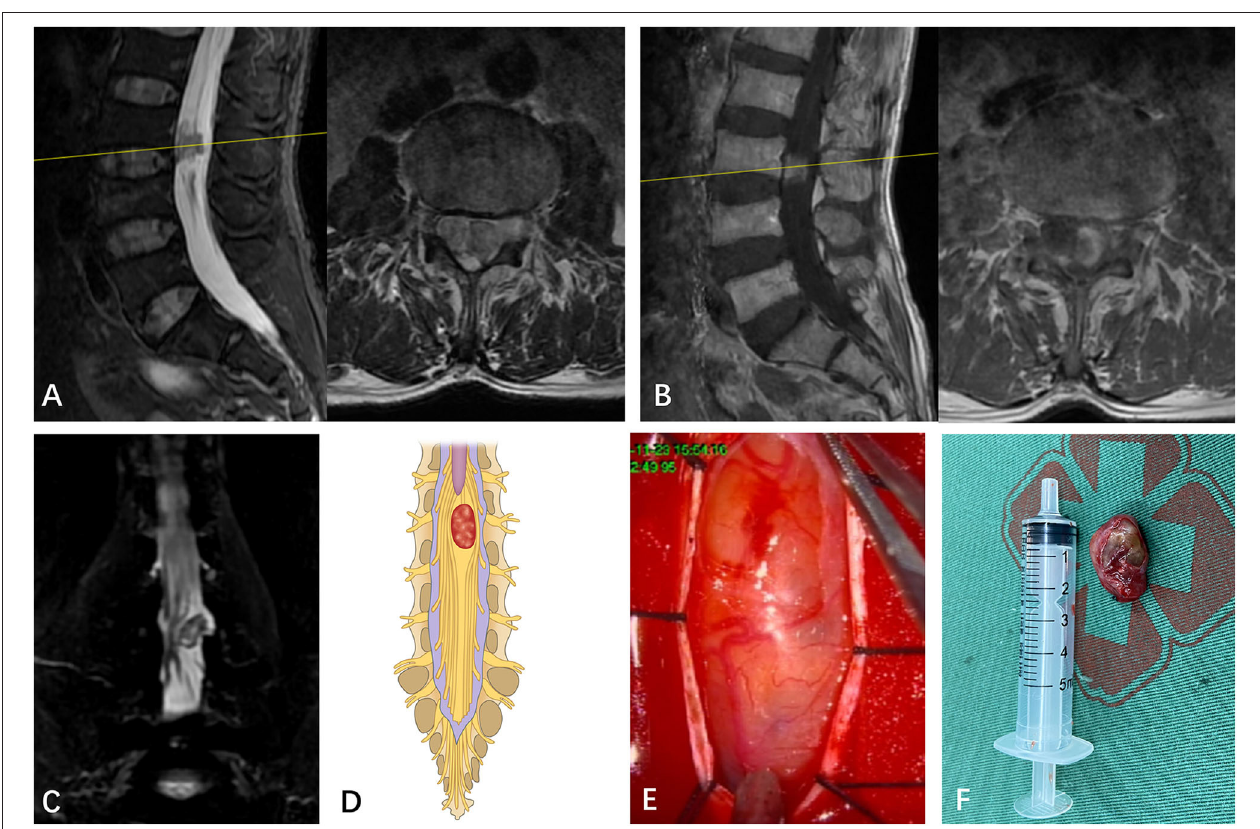
FIGURE 2 | (A) A subdural mass with hypersignal T1 and T2 was identified on a segment of T12 in a 58-year-old man via preoperative MRI. (B) The mass presented inhomogeneous enhancement via Gd MRI. (C) Though both preoperative MRI and Gd MRI did not identify the spatial relationship between the tumor and the spinal nerve, the CMRI clearly showed that a part of the nerves enter the tumor and terminate at the end of the tumor. (D) Based on the spatial relationship between the tumor and the spinal nerve, the case was considered type II according to the pattern diagram. (E) As expected, an intraoperative observation confirmed that a part of the nerves enters the tumor and terminates at the end of the tumor (type II). (F) The mass was resected and confirmed to be schwannoma by postoperative